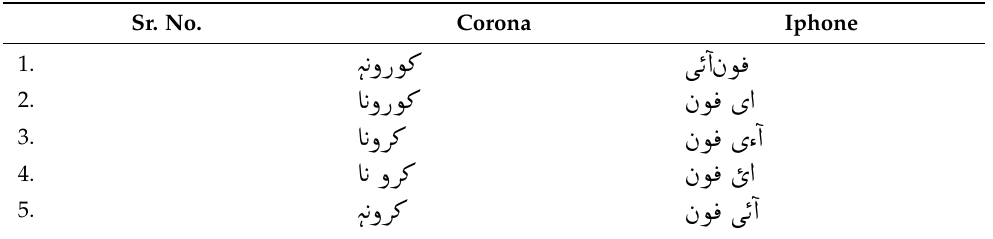
Table 14. Examples of spelling variations of the terms: Corona and Iphone in the Urdu web query dataset. These variations represent coverage challenges for learning models.